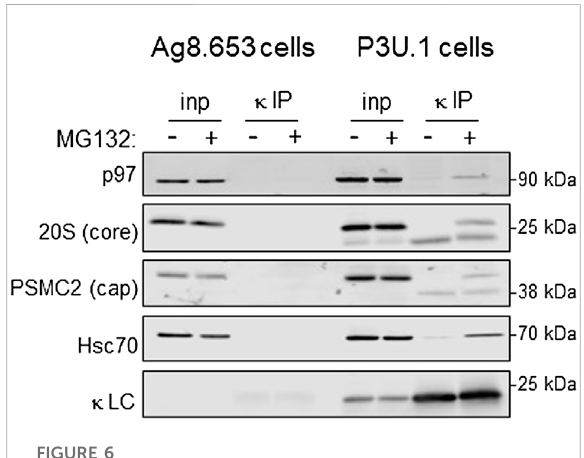
FIGURE 6 Proteasomal inhibition results in the association of retrotranslocated κ LCs with AAA-ATPase base and 20S core subunits. (A) P3U.1 ( κ + ) and Ag8.653 (Ig − ) cells were incubated with MG132 (+) or DMSO (-) for 3.5 h. Prior to lysis, cells were crosslinked withDSP toretain protein:proteininteractions. Lysates were prepared using RIPA buffer; a portion was removed for input, and the remainder was immunoprecipitated with anti-LC- conjugated agarose beads. Immunoprecipitated material (IP) and total lysate samples (input) were separated on reducing SDS-gels and analyzed by western blotting with an anti-p97, anti-20S proteasome core α subunit, anti-PSMC ATPase regulatory particle subunit, anti-Hsc70, or anti- κ